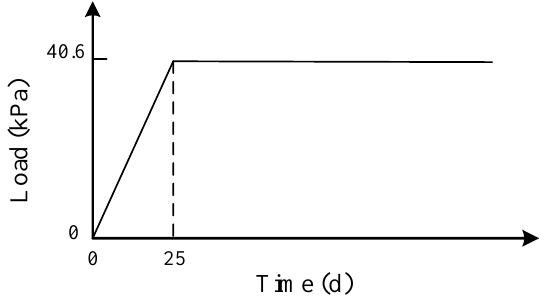
Figure 3. The diagram of the loading process. Table 1. Recompiled soil parameters after Mesri and Choi